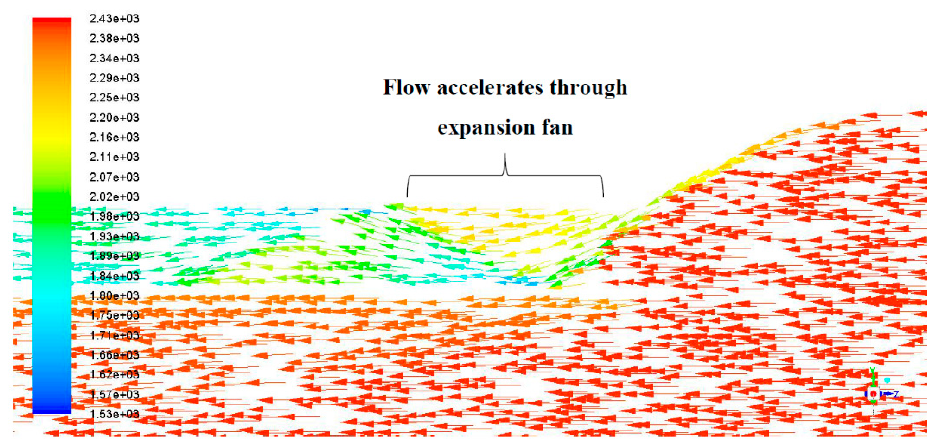
Figure 33. Velocity vectors on the symmetry plane of the 3-D inlet for flight at Mach 8.